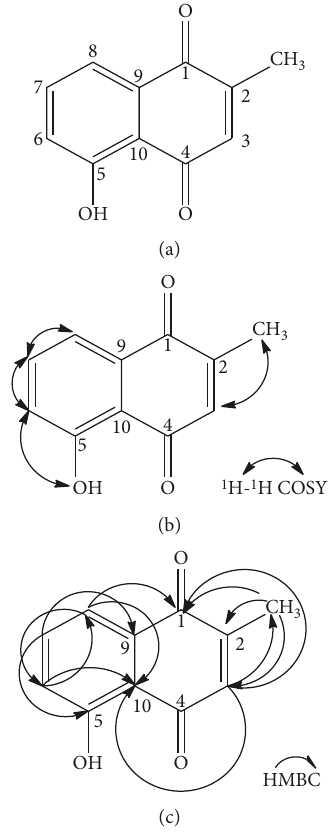
Figure 1: (a) Plumbagin. (b) 1 H- 1 H COSY of plumbagin. (c) Key HMBC correlations of